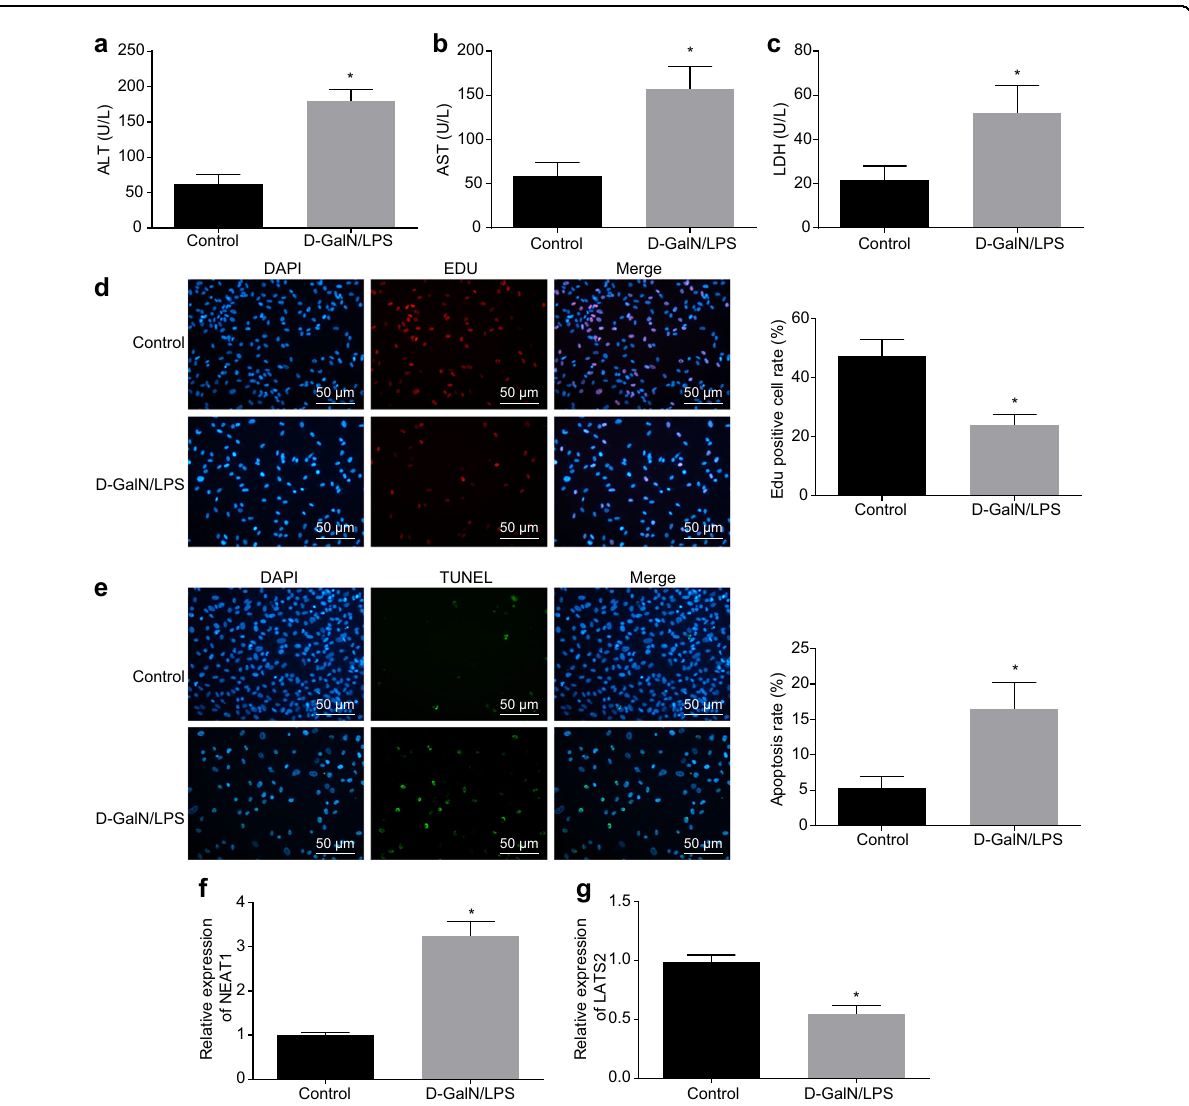
Fig. 1 Apoptosis and lncRNA NEAT1 expression increased in D-GalN/LPS-treated cells, whereas LATS2 expression decreased. ALT, AST, and LDH expression patterns in HL-7702 cells with or without D-GalN/LPS treatment ( a – c ). The proliferation of HL-7702 cells was determined by EdU assay (×200) ( d ). The apoptosis of HL-7702 cells was determined by TUNEL staining (×200) ( e ). The lncRNA NEAT1 expression patterns in HL-7702 cells determined by RT-qPCR ( f ). The mRNA expression patterns of LATS2 in HL-7702 cells determined by RT-qPCR ( g ). Control, HL-7702 cells without treatment; D-GalN/LPS, HL-7702 cells treated with D-GalN/LPS; * p < 0.05 vs. control. Statistical data are described as mean ± standard deviation. Independent sample t test was used for comparisons between two groups. The experiment was repeated three times independently.